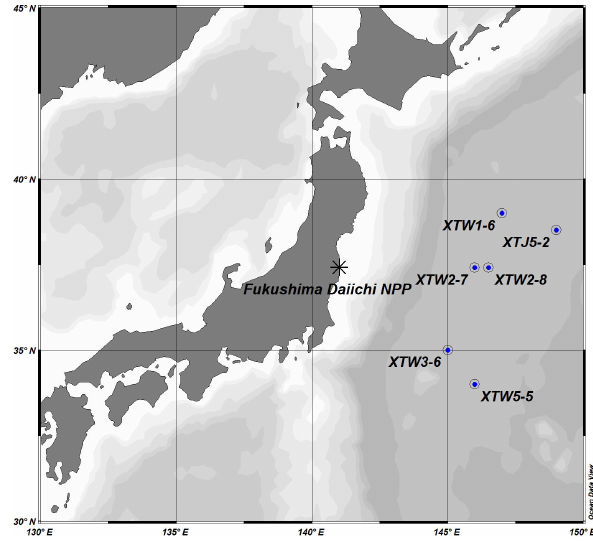
Figure 1. Map of sampling